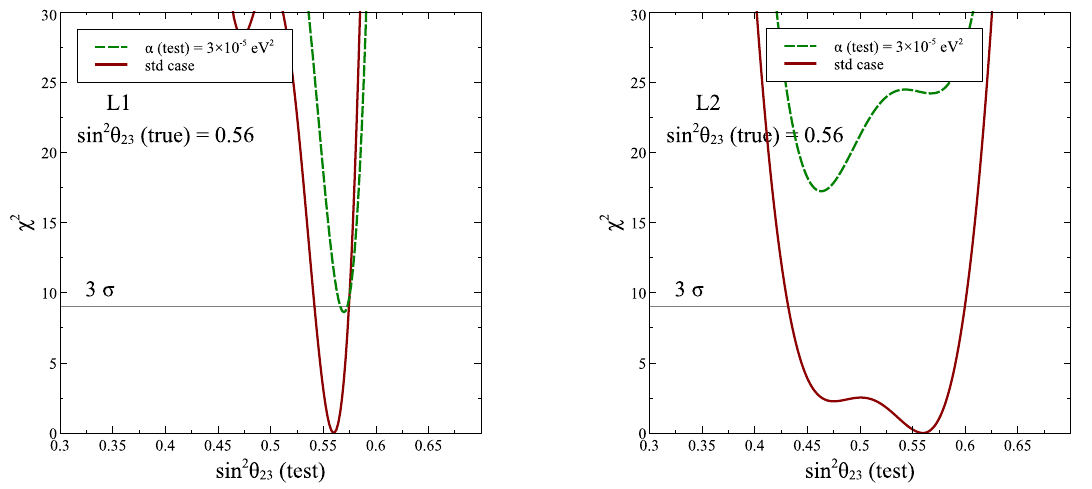
Figure 6 . The χ 2 as a function of θ 23 assuming true sin 2 θ 23 = 0 . 56 . The left (right) panels are for baselines 295 (1100) km respectively. The dark red solid curves are for the standard cases and the green dashed curves are for the case when α = 0 in the simulated data but assumed to be 3 × 10 − 5 eV 2 in the